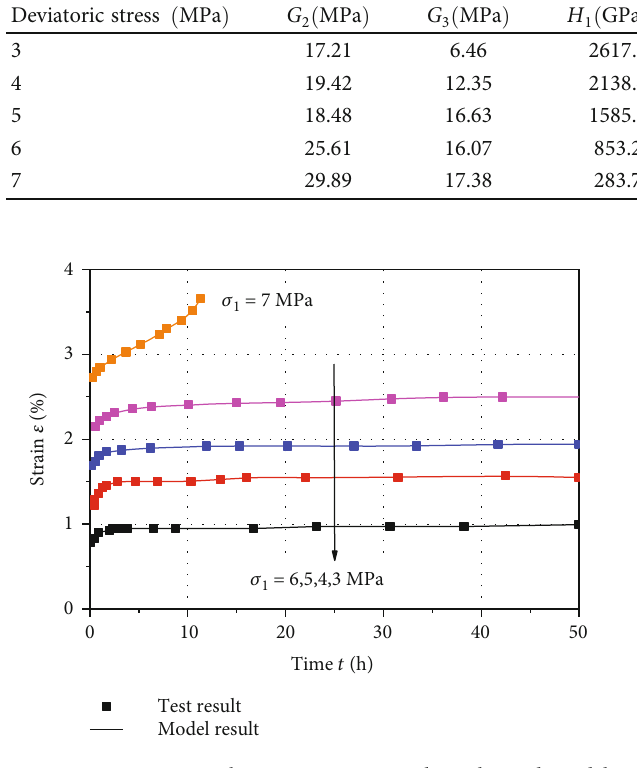
Figure 8: Comparison between experimental results and model calculation